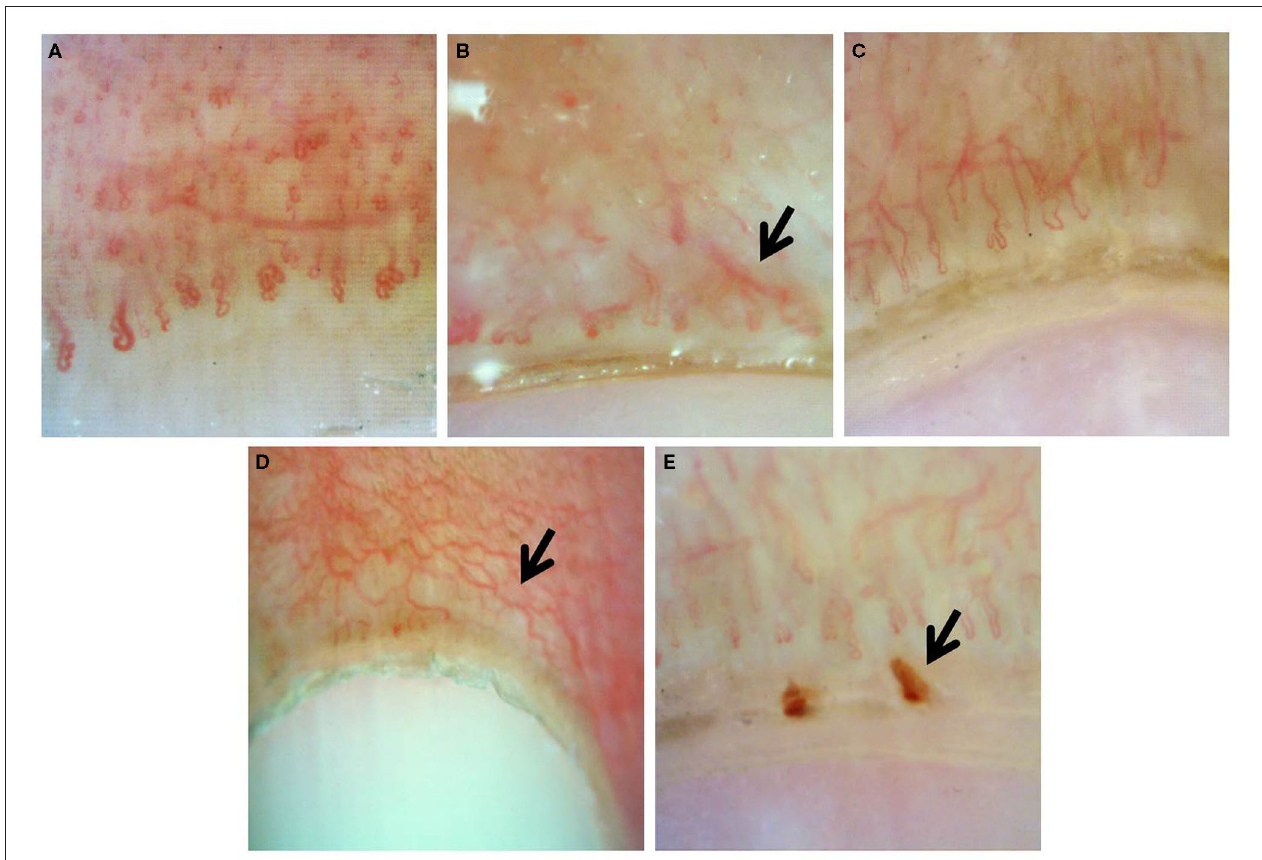
FIGURE 1 | Onychoscopic morphologic features: (A) tortuous capillaries, (B) bushy capillaries, (C) elongated capillaries, (D) prominent subpapillary plexus, and (E) capillary